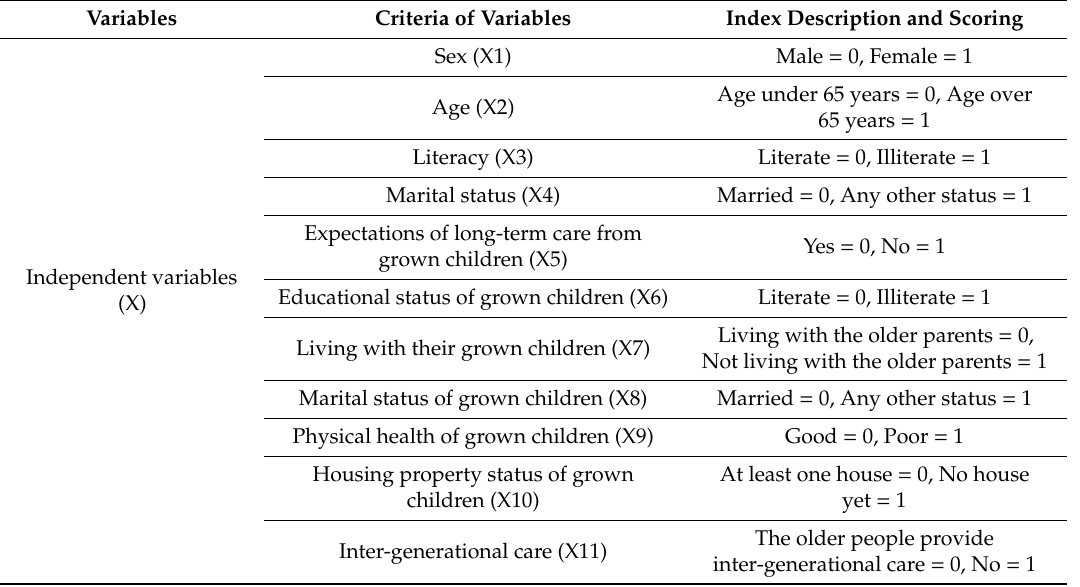
Table 2. Variables and descriptive statistics.